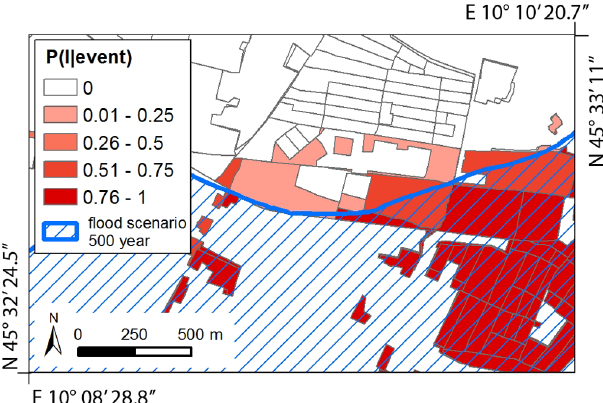
Fig. 3. Example of calculation of flood P(I | event) for census